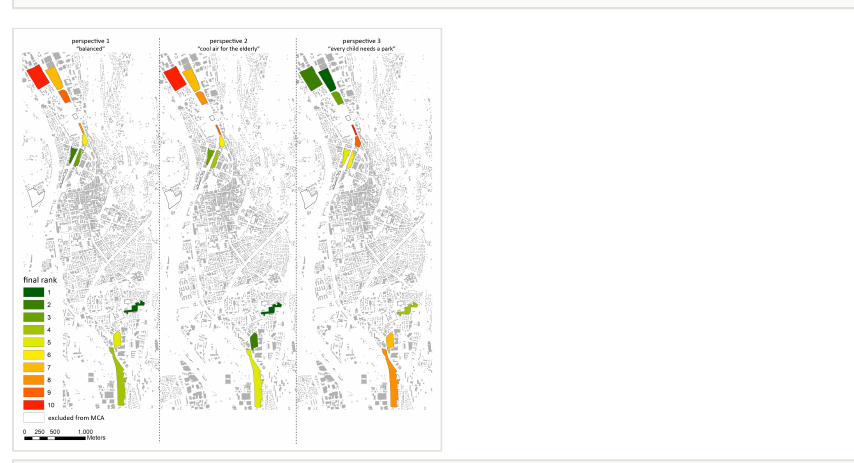
Map of the priority level of brown fi eld regeneration scenarios according to three perspectives considered in the multi-criteria